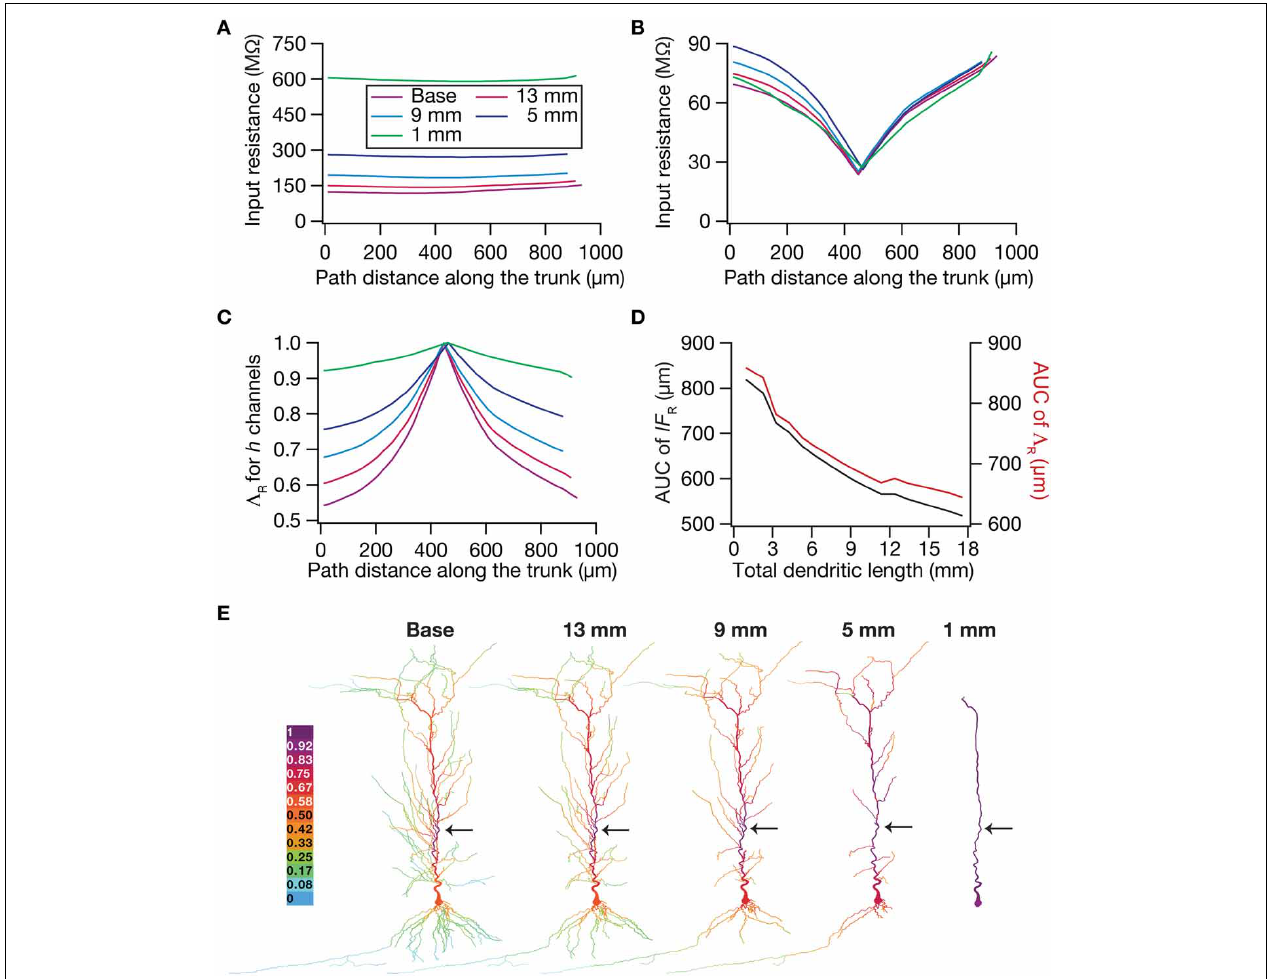
the somato-apical trunk for different morphologies. (D) Area under curve (AUC) for unnormalized (black) and normalized (red) influence field, plotted as functions of dendritic length of the neuronal morphology under consideration. (E) Color-coded influence field across the entire dendritic arbor showing the effect of a single HCN-channel cluster located (black arrow) at ∼ 450 μ m from the soma on R in for various